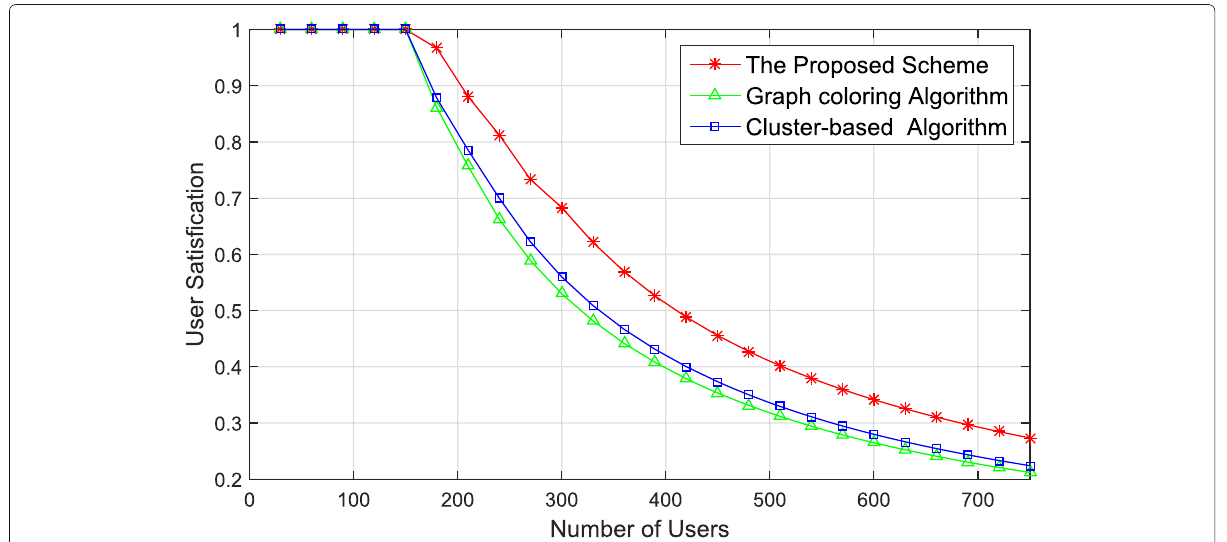
Fig. 8 Comparison of user satisfaction. Users include those with access and those denied access